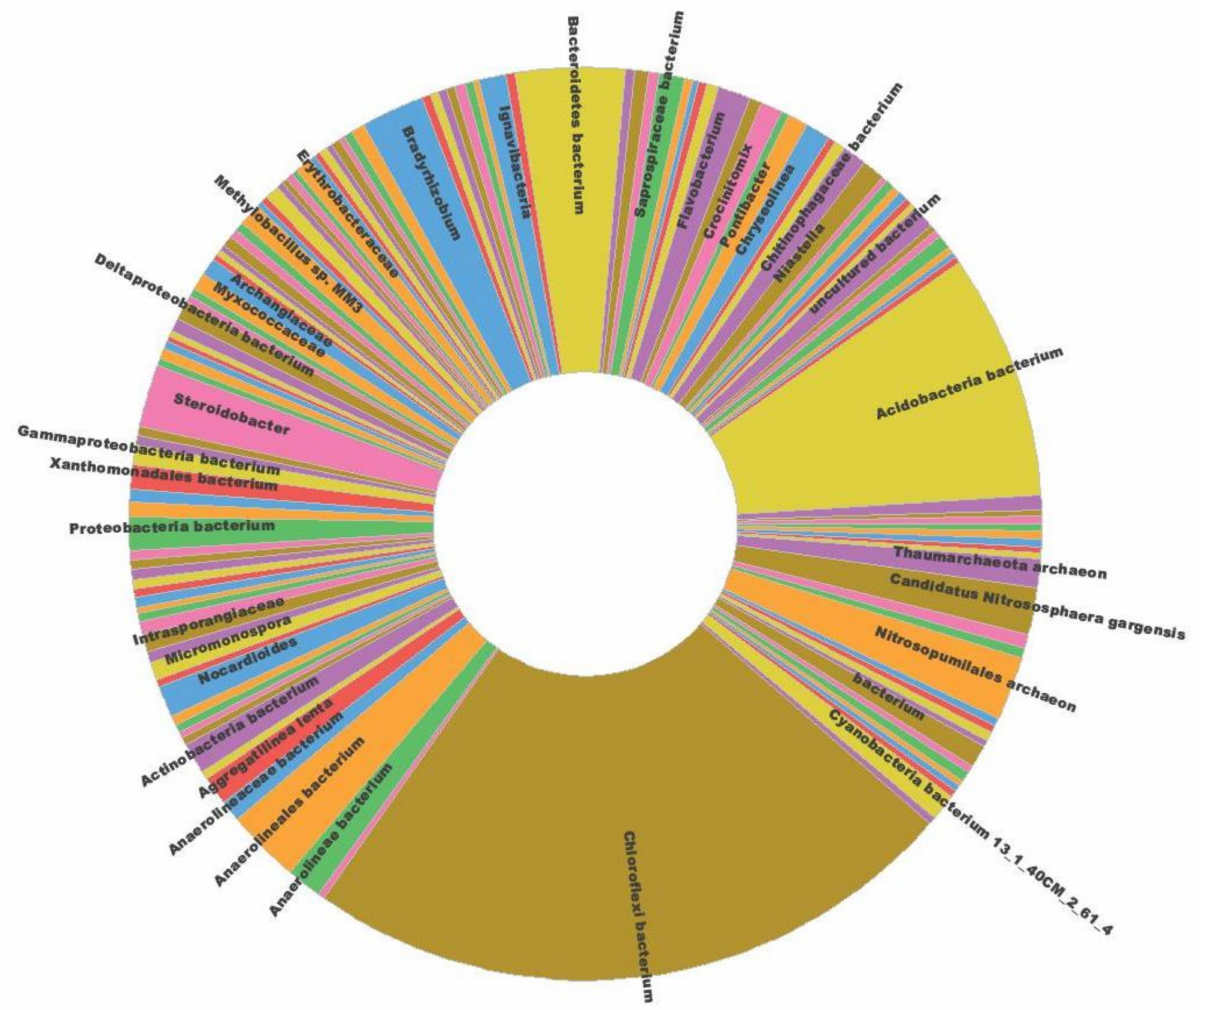
Figure 2. Major microbes identified in the ZBNF soil after Jeevamrit application. Application of Jeevamrit improved the microbial diversity and load in the ZBNF field. The rich bacterial and fungal diversity shown in the figure indicates the contribution of these microbes to the soil fertility and